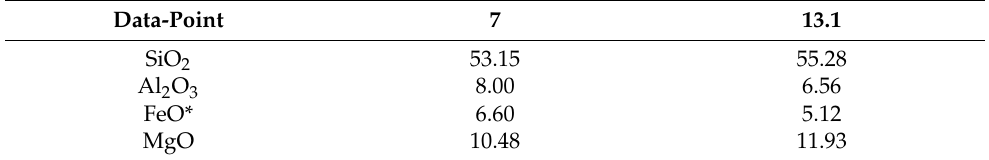
Table 3. Chemical composition (wt.%), formula units, and major component contents (%) of om- phacite in inclusions in Zrn-II crystals from massive eclogite